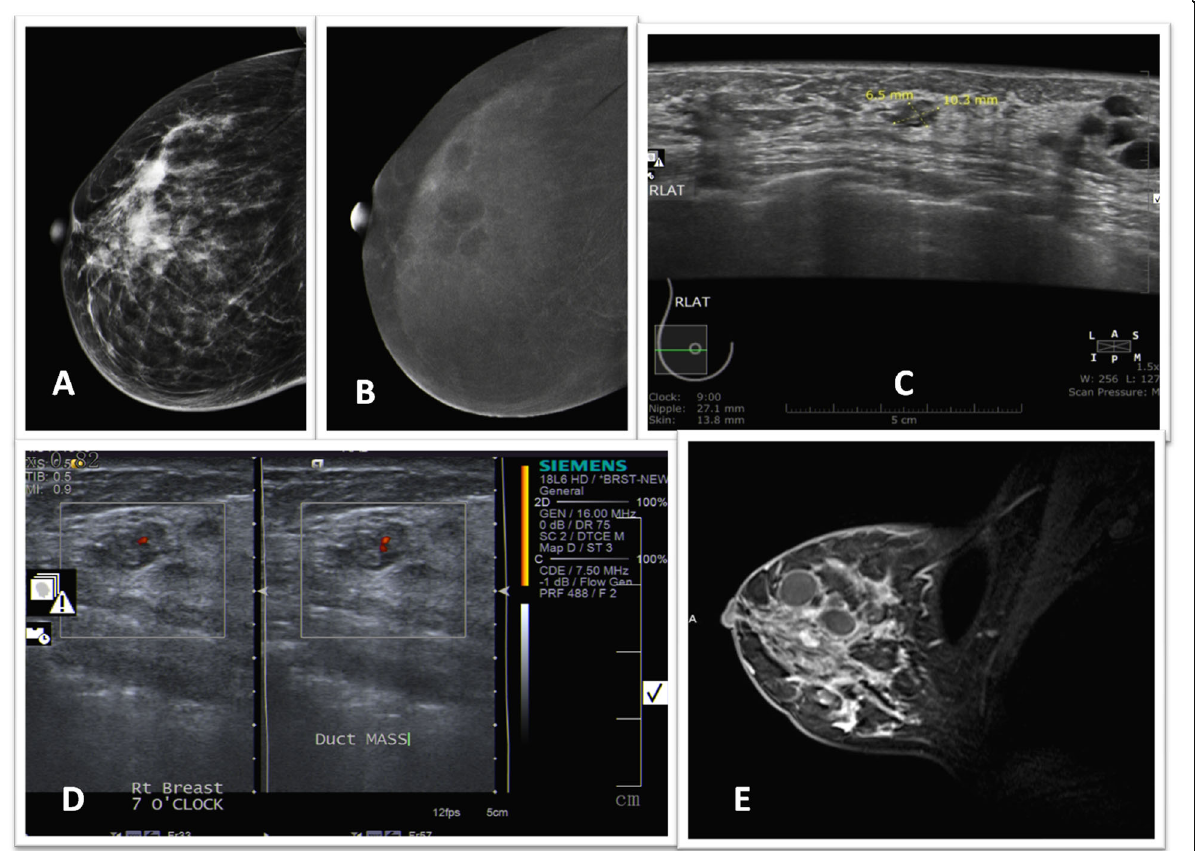
Fig. 1 A 48-year-old lady with bilateral breast lumps. No bleeding per nipple. a Rt. CC digital mammogram shows LOQ mass. b Recombined CESM image CC view Rt. Breast shows small focal area of moderate nodular mass enhancement. Associated cysts giving the eclipse sign. c 3D ABUS (axial) shows intraductal soft tissue at 7 o ’ clock of the Rt. breast 27 mm from the nipple, 13 mm from the skin. d 2D HHUS with color doppler shows a central vascular pedicle within the mass at the same location. e DCE-MRI delayed sagittal image confirmed moderate lesion enhancement with a type I (persistent curve)-not shown. Pathology revealed intraductal